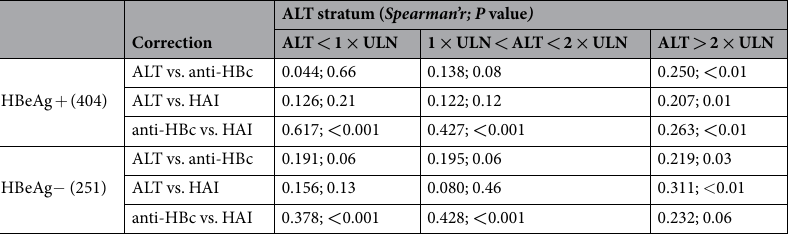
Table 2. Correlation between histology activity index score and anti-HBc levels, ALT levels according to the ALT stratum. ALT, alanine aminotransferase; HBeAg, hepatitis B e antigen ULN, upper limit of normal; HAI, histology activity index.